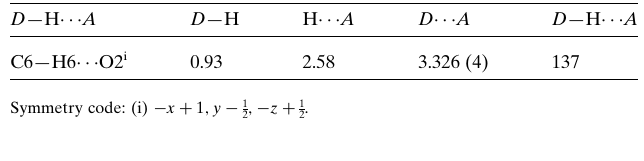
Table 2 Experimental details.